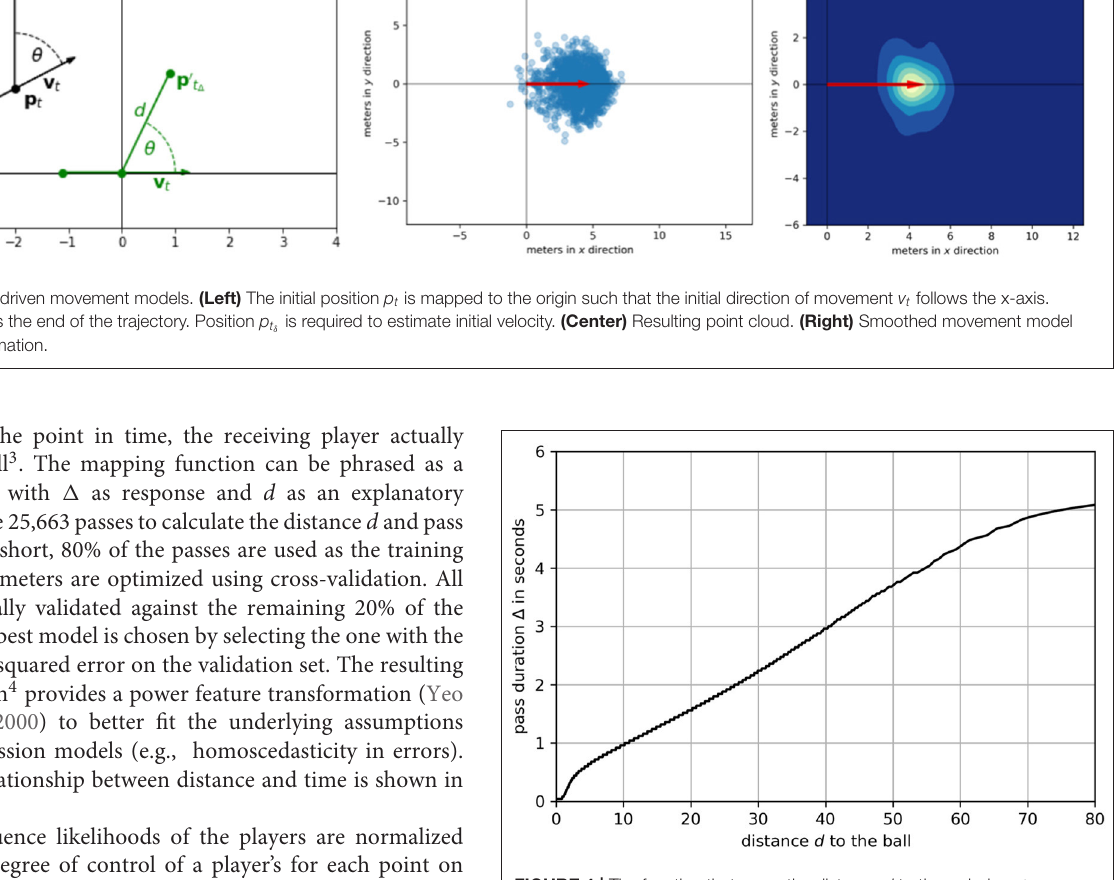
FIGURE 4 | The function that maps the distance d to time window 1